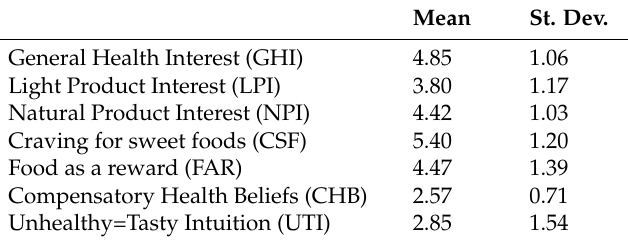
Table 3. Participants’ psychographic characteristics.